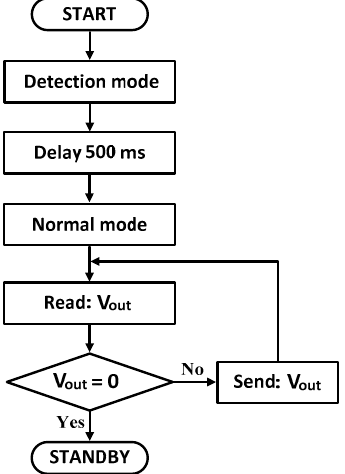
Figure 13. Program flowchart of the secondary-side controller.